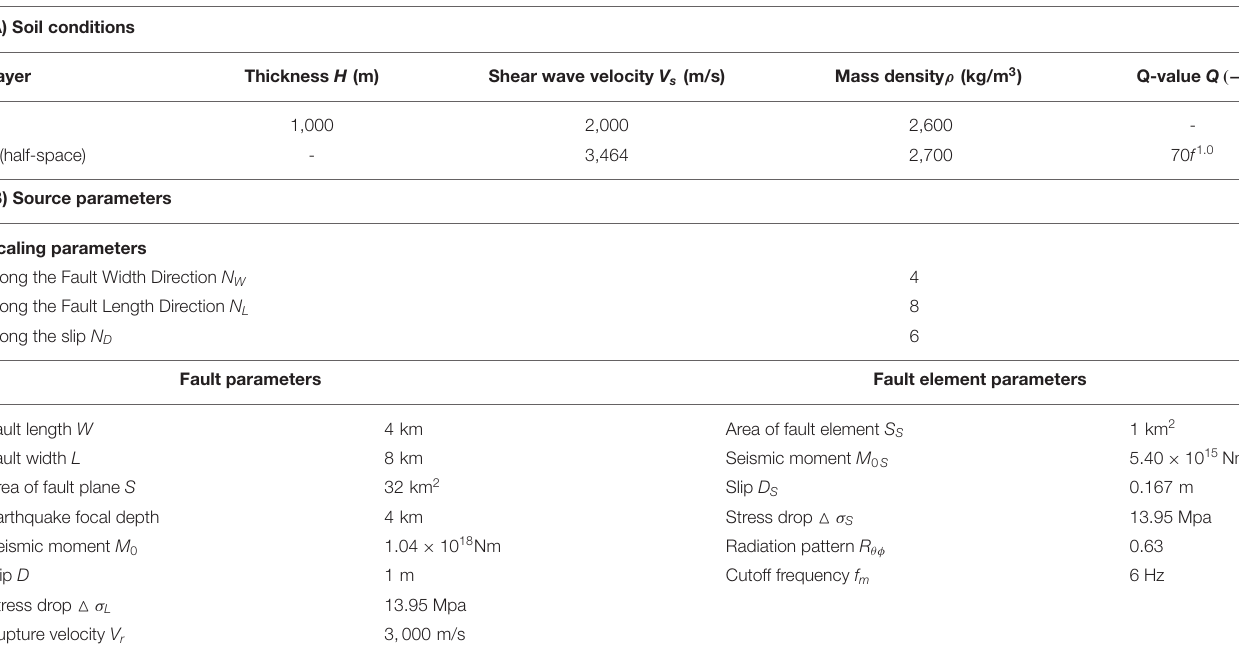
TABLE 1 | Soil conditions and source